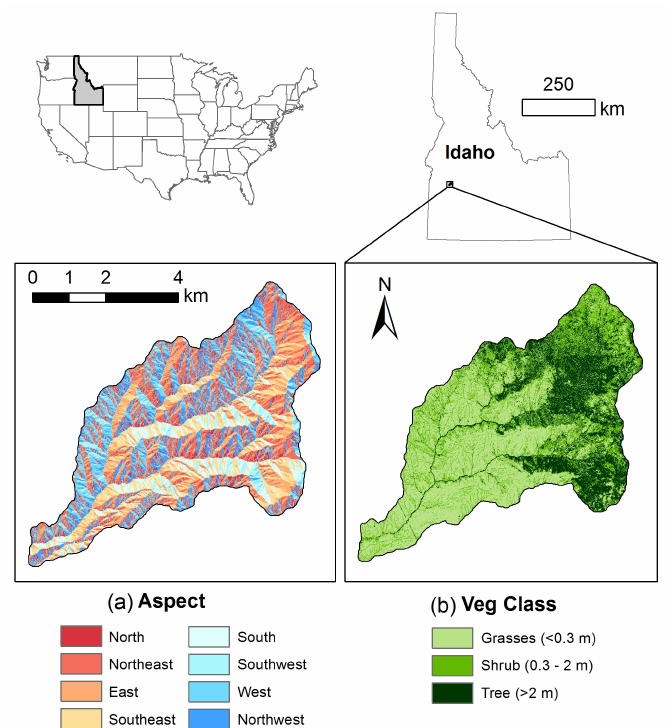
Figure 1. Location of Dry Creek Experimental Watershed (DCEW) in Idaho, USA. We created a LiDAR-derived aspect layer ( a ), and a layer of dominant vegetation functional type ( b ). DCEW has a strong vegetation gradient with tree-dominated areas largely contained to the eastern half of the